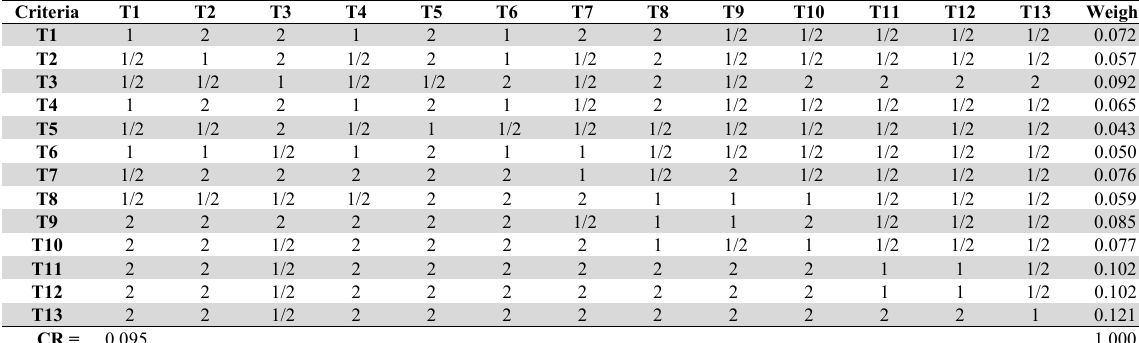
Pairwise comparison matrix aggregation for Threat aspects Criteria